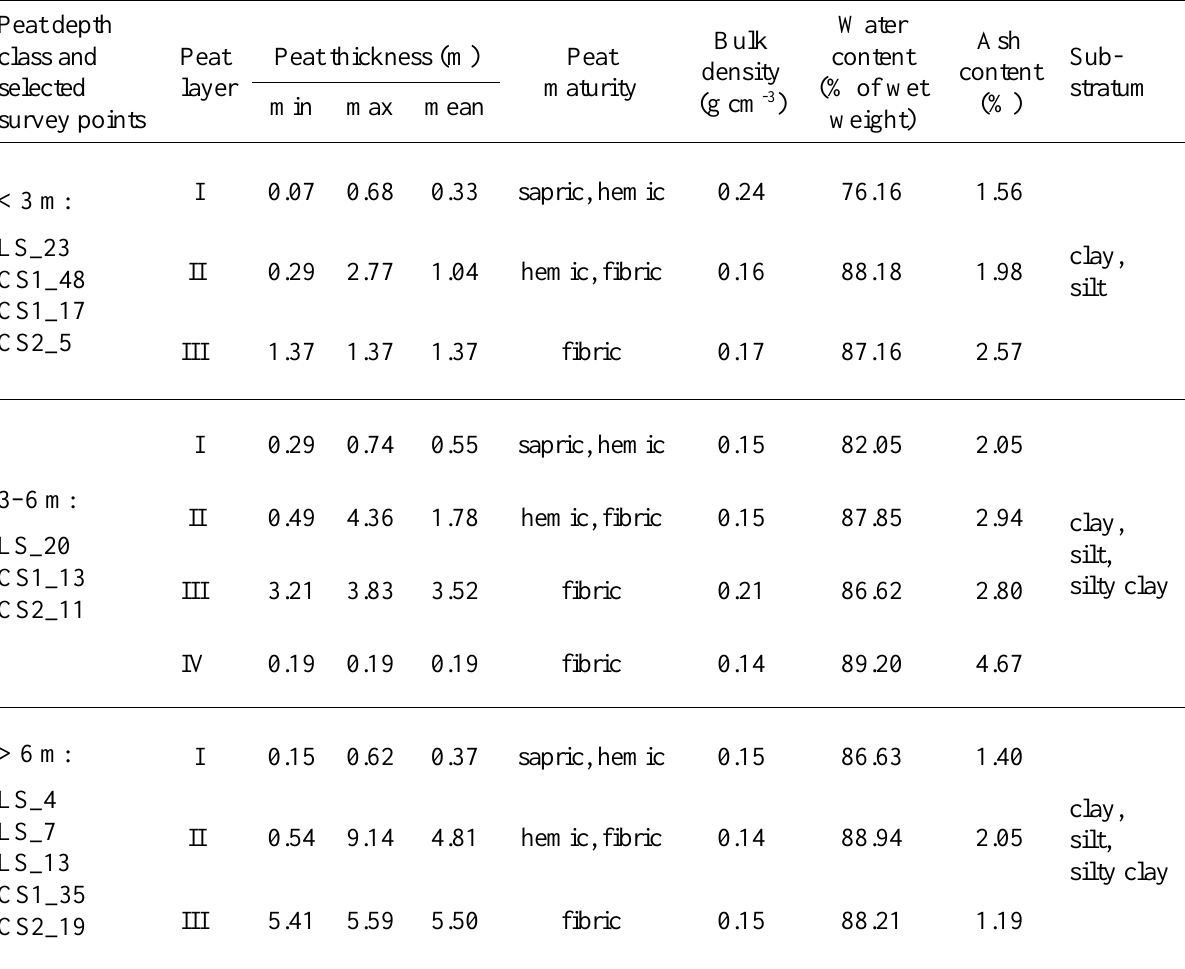
Table 2. Characterisation of peat thickness and mineral substratum at 12 selected survey points on Transects LS, CS1 and